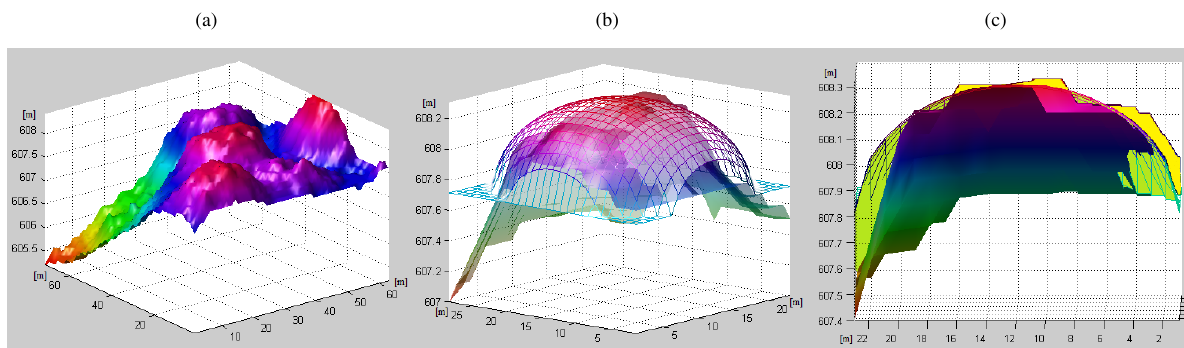
Figure 2. From left to right respectively: original location of the tumulus used for demonstration (the middle one), tumulus with the approximated ideal ellipsoid surface, cross-section of tumulus with differences from the ellipsoid surface (yellow – positive, green –